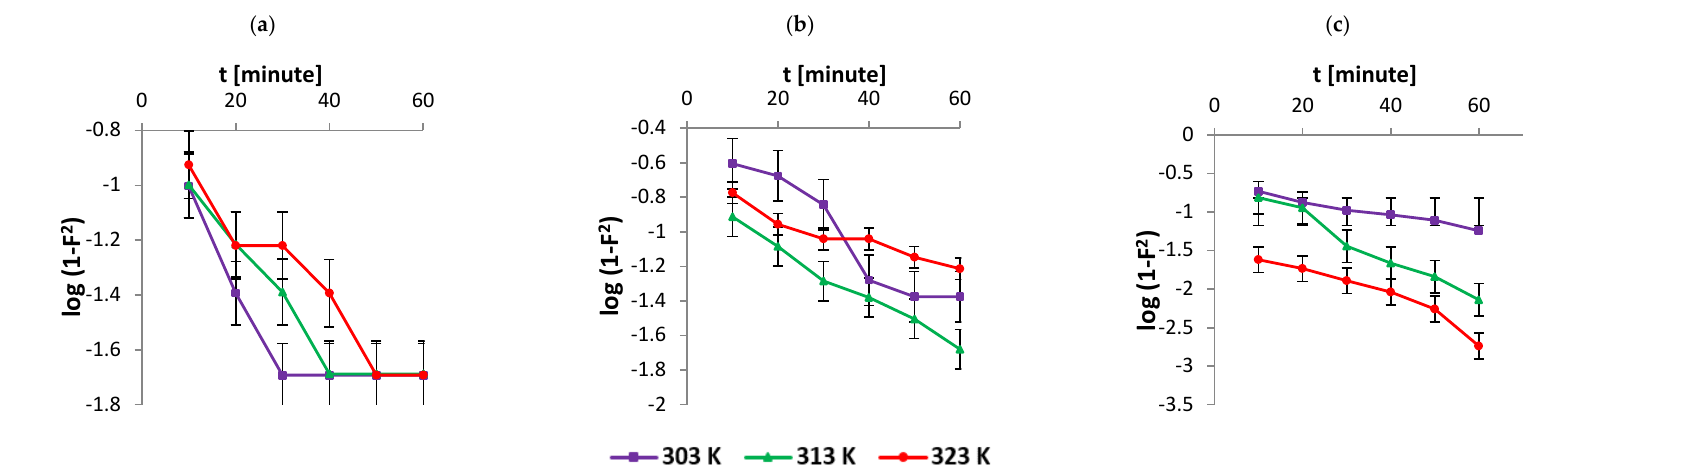
Figure 4. Kinetics data fitted to the Dumwald – Wagner model with initial AR119 concentration ( a ) 100 µg mL −1 , ( b ) 200 µg mL −1 and ( c ) 300 µg mL −1 . Table 2. Calculated parameters for diffusion models.